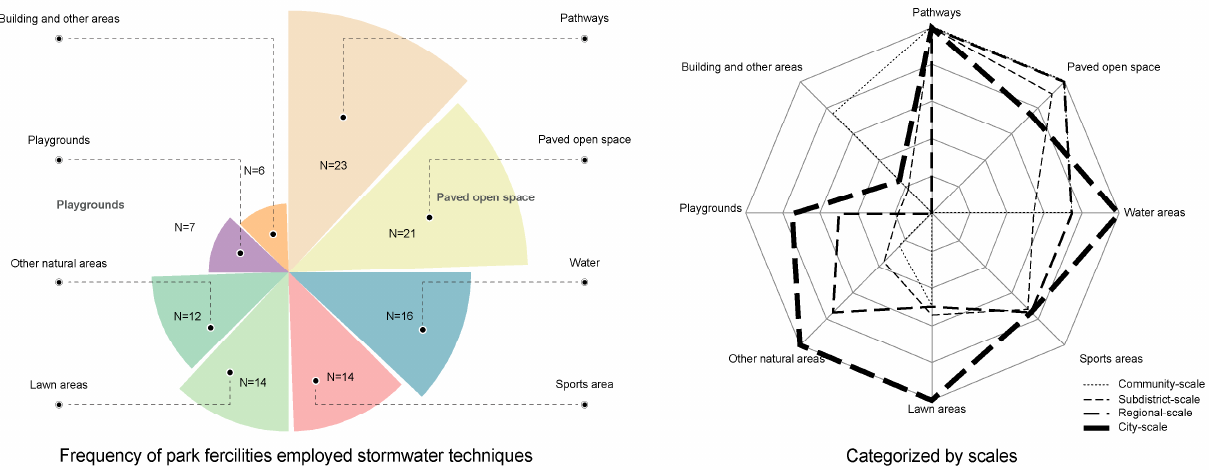
Figure 6. The combinations of park facilities and stormwater